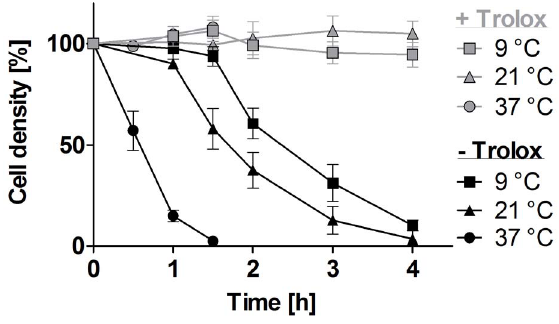
9 6 10 5 cells/ml in standard HMI-9 medium (which contains 10% FCS) supplemented 6 100 m M Trolox. The cells were incubated at 37 u C, 21 u C, and 9 u C, respectively. At the indicated time points, living cells were counted. The values represent the mean 6 SD of three independent experiments.